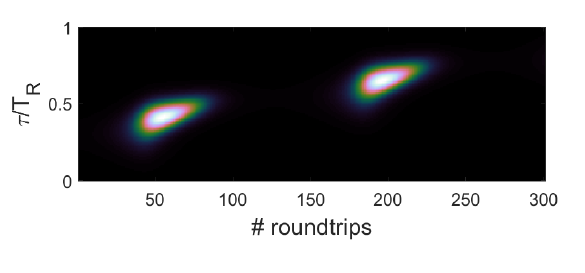
Figure 1. Example of Q-switched modelocking (QSML). The pulse is modulated from zero to a maximum value with a period of about 150 roundtrip times.